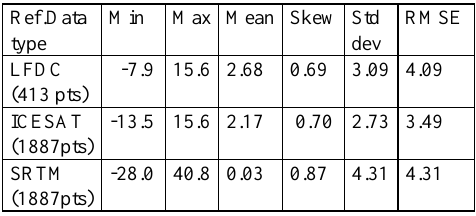
Table 6. Statistics of difference between TanDEM-X DEM and reference data sets with selected point data.